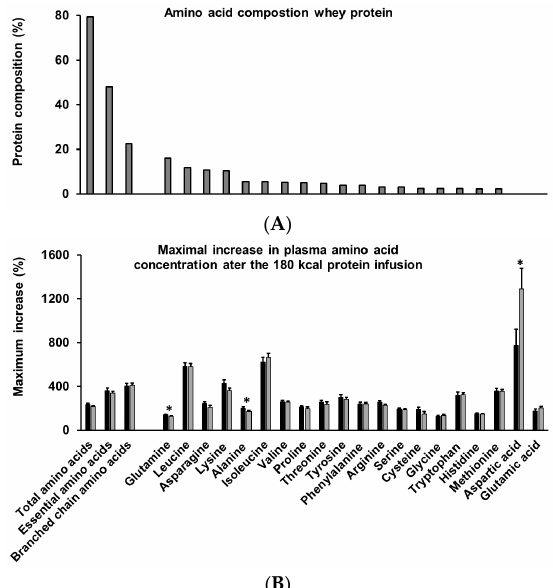
Figure 1. Amino acid composition of the intraduodenally infused whey protein hydrolysate ( A ) and increase of amino acid concentrations at 60 min during the 180 kcal whey protein infusion as a percentage of baseline in healthy younger ( n = 10 ( n = 9 for histidine); black bars) and older ( n = 10; grey bars) men ( B ), ranked in order of high to low amino acid content (g/100 g). Essential amino acids: histidine, isoleucine, leucine, lysine, methionine, phenylalanine, threonine, tryptophan, and valine. Branched-chain amino acids: isoleucine, leucine, and valine. Differences between older and younger men were determined using an independent sample t -test. Statistical significance was accepted at p < 0.05. * p < 0.05 older compared to younger men.